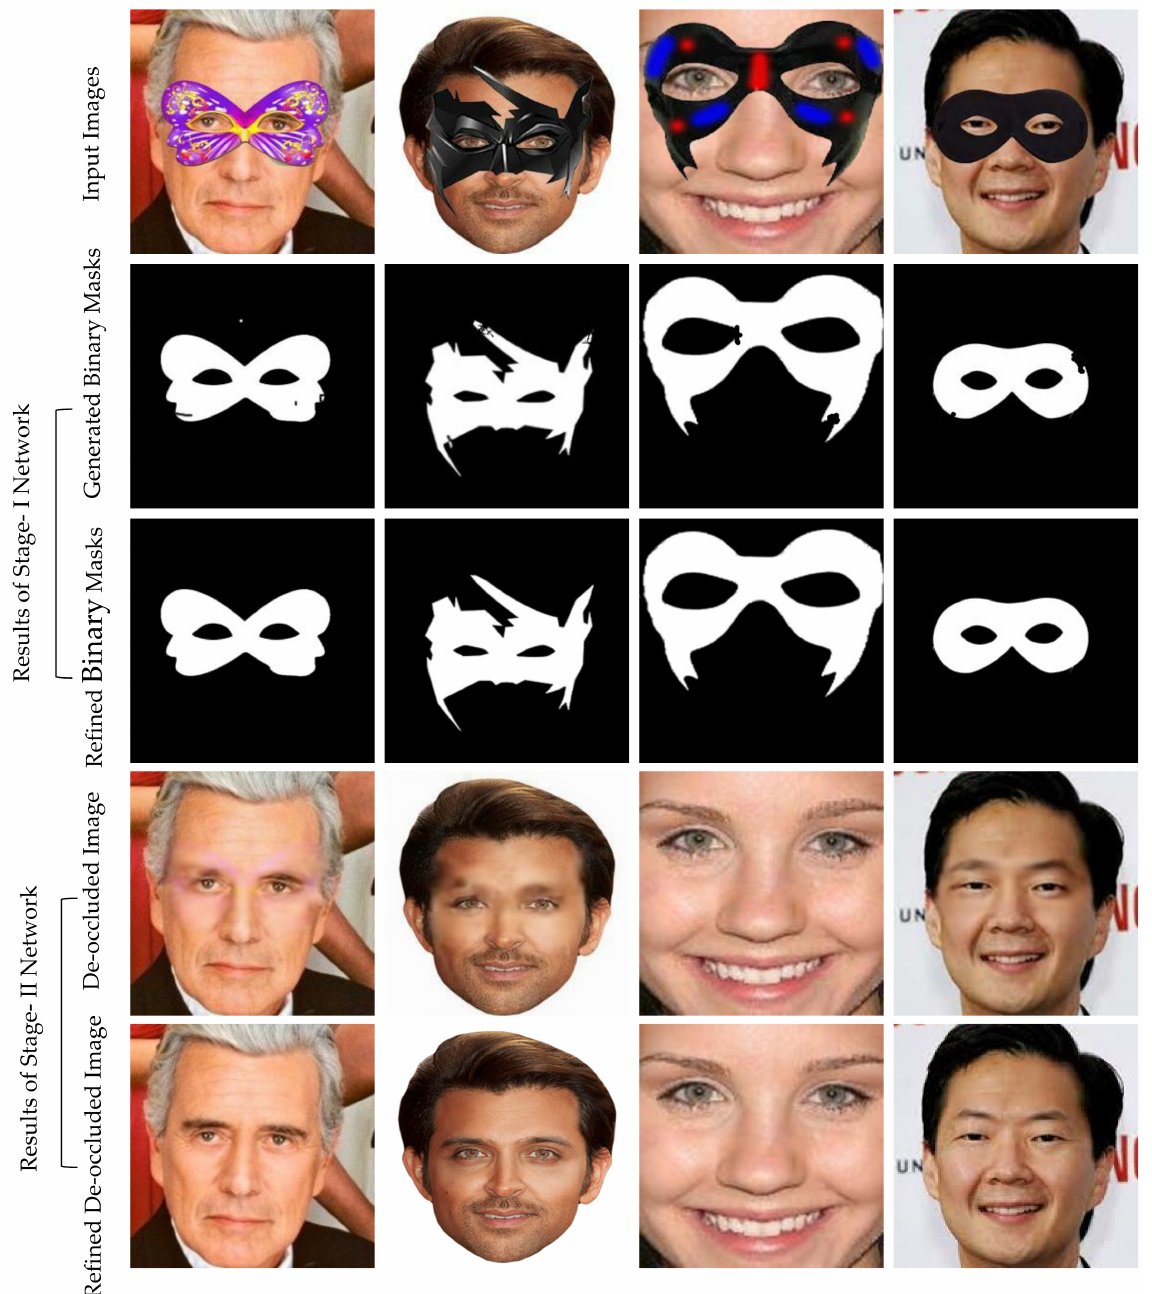
Figure 5. The results of AFD-StackGAN (Stage-I Network + Stage-II Network) on real-world